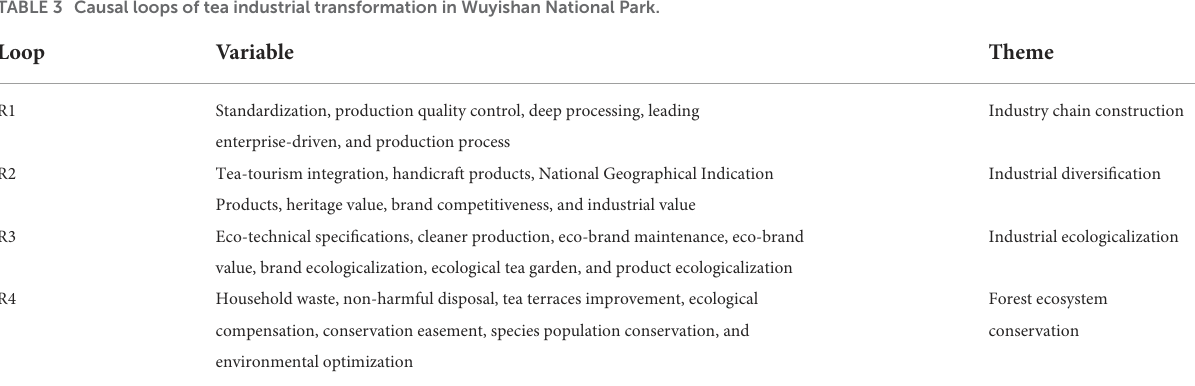
TABLE 3 Causal loops of tea industrial transformation in Wuyishan National